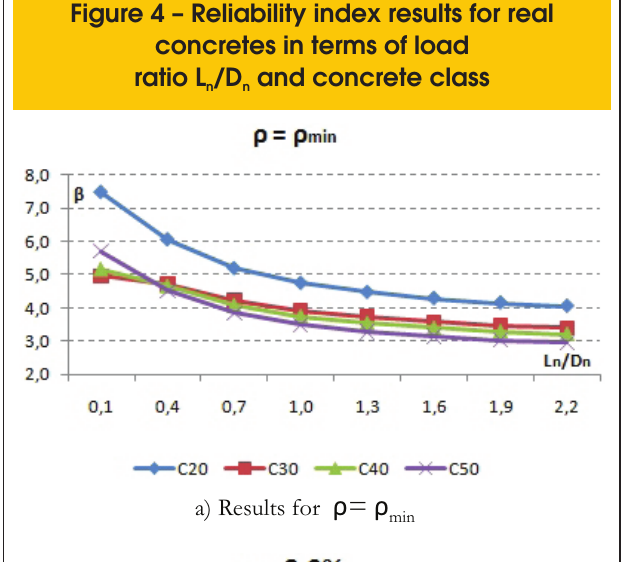
Figure 4 – Reliability index results for real concretes in terms of load